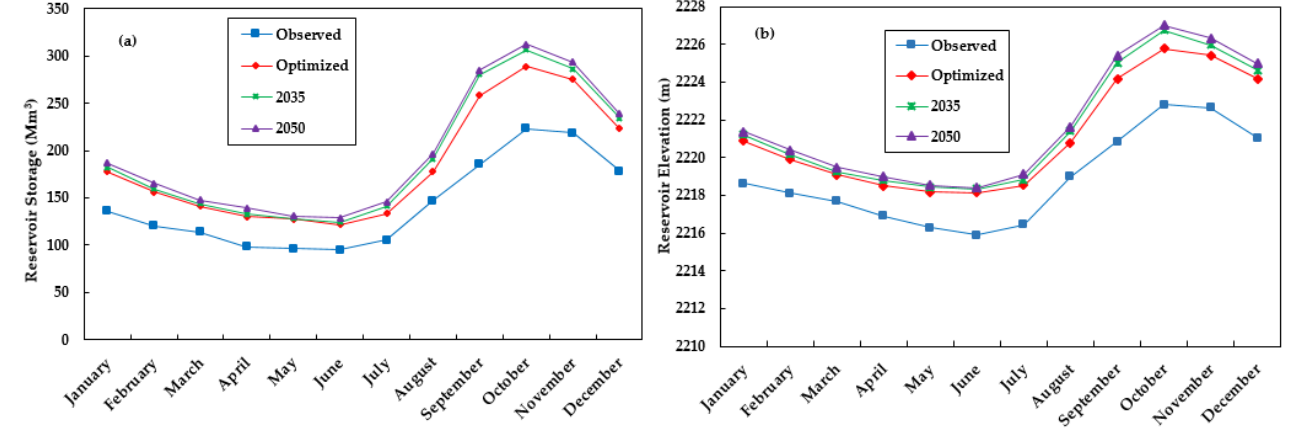
Figure 14. Nashe reservoir mean monthly power storage ( a ) and pool level ( b ) rule curves for current and future time periods.